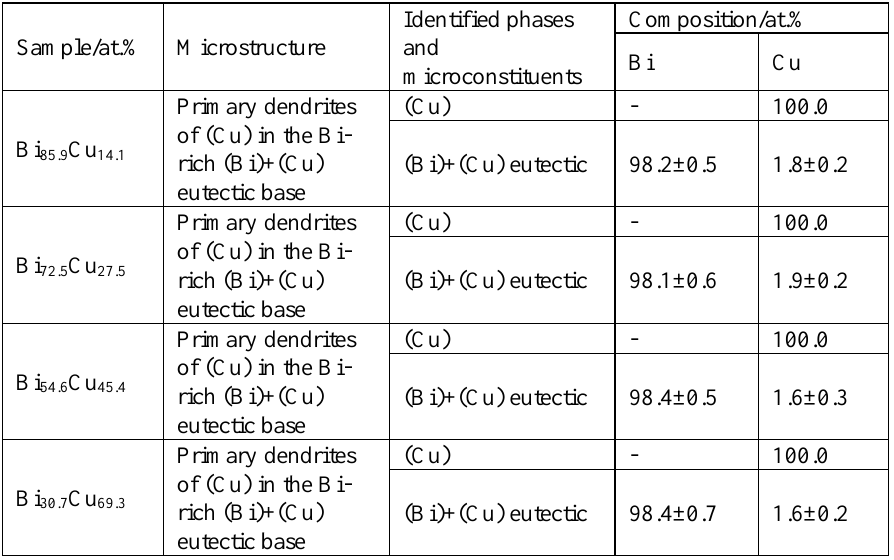
Table 1. The results of SEM-EDS